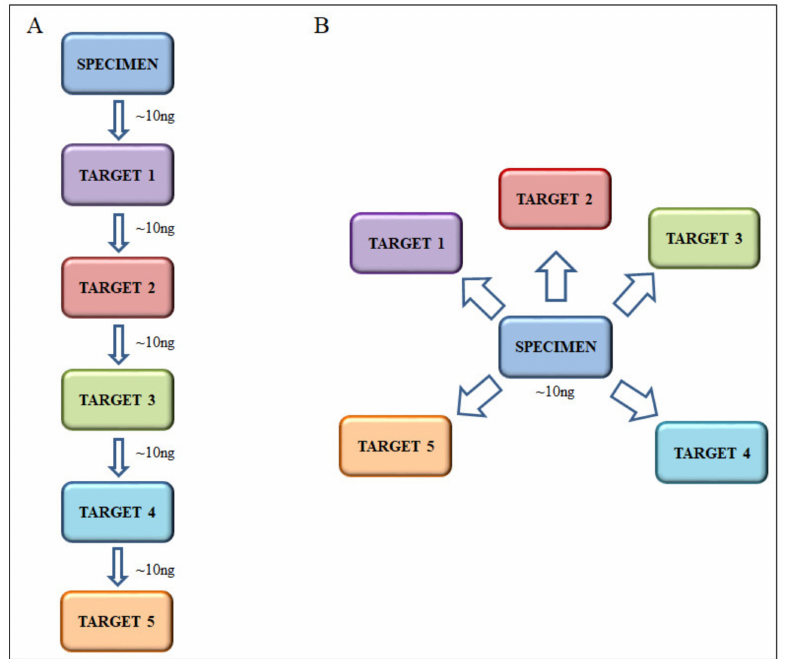
Figure 4. Schemes of molecular analysis using “sequential” ( A ) or “parallel” ( B )